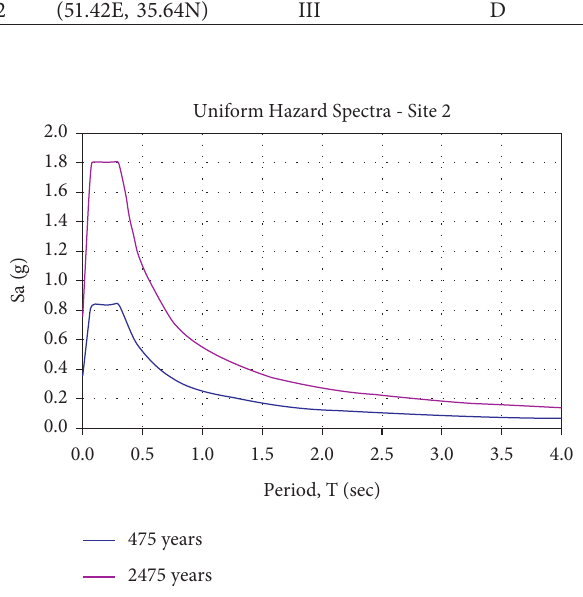
Figure 6: Uniform hazard spectrum of 475 and 2475 years of site no. 2